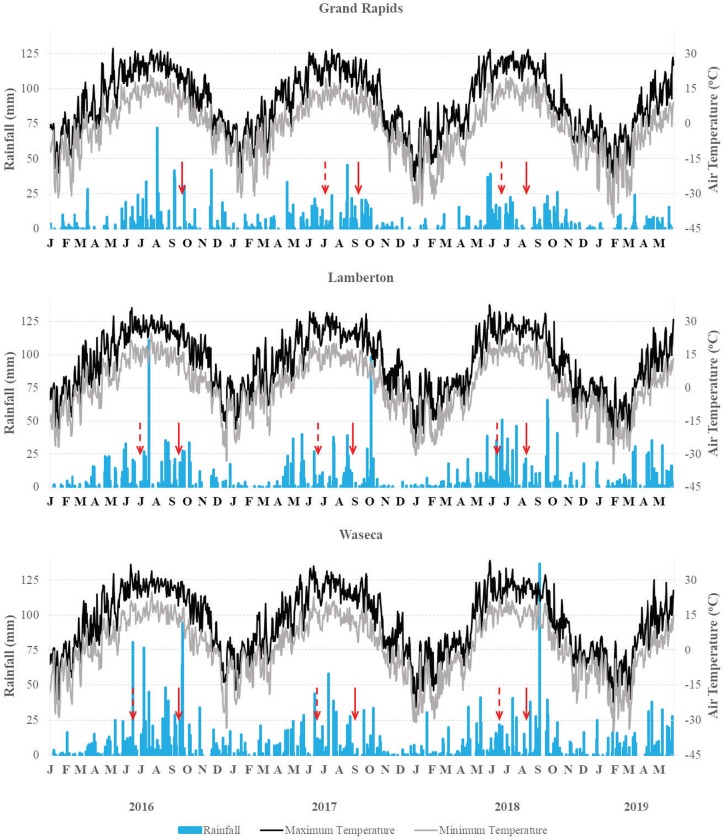
Weather conditions during the experimental years.Red arrows denote early- (dotted) and late-interseeded dates, approximately.